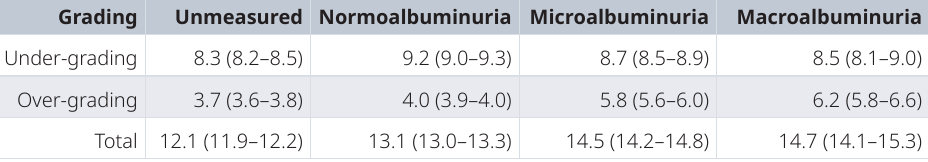
Table 2. Probability (%) that any eGFR test is under-graded and/or over-graded, by albuminuria stage. 95% confidence intervals shown in brackets.